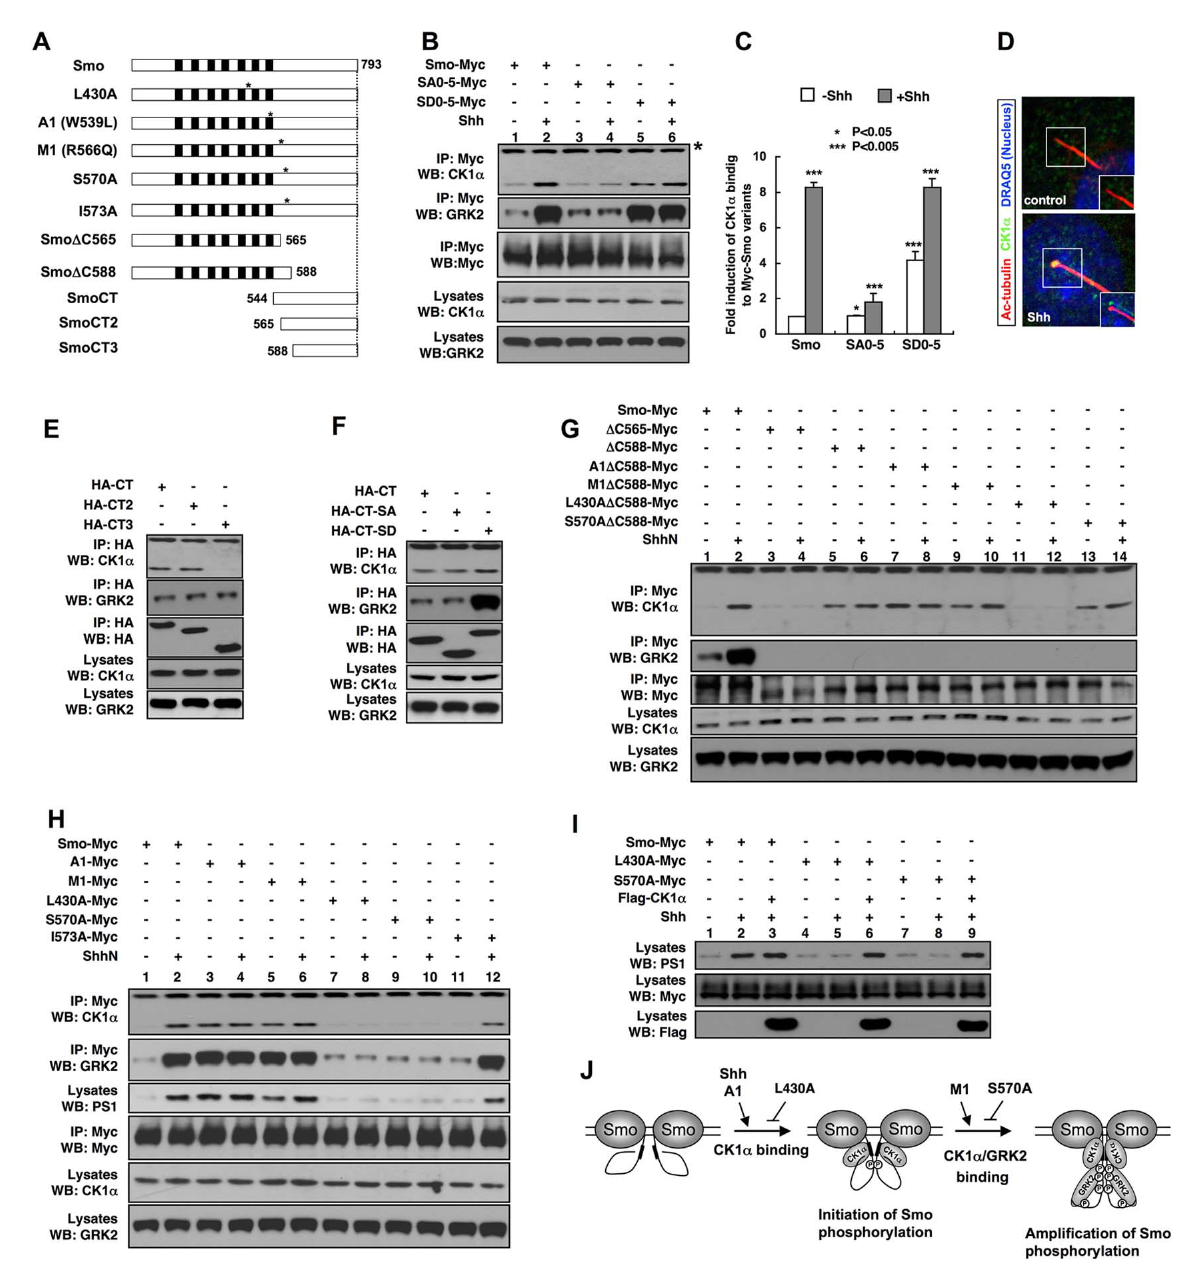
Figure 7. Shh promotes CK1 a /GRK2 binding to Smo. (A) Schematic drawings of full-length and truncated Smo with point mutations indicated by the asterisks. Black boxes denote the transmembrane domains. L430A is located in the third intracellular loop; A1 in the seventh transmembrane domain; M1, S570A, and I573A are located in the membrane proximal region of the Smo C-tail. (B–C, E–H) Coimmunoprecipitation assays to determine the interaction between CK1 a /GRK2 with different forms of Smo. NIH 3T3 cells were transfected with the indicated Myc-tagged or HA- tagged Smo constructs, followed by immunoprecipitation and western blot analysis with indicated antibodies. Cell lysates were also directly immunoblotted by the indicated antibodies. Histogram in (C) shows the quantification of (B) with CK1 a binding normalized by the Smo input and compared with lane 1. * p , 0.05, ** p , 0.01, *** p , 0.005. Western blots were quantified using the ImageJ software followed by Prism analysis, n =3. Quantifications of (G) and (H) are shown in Figure S5. (D) NIH 3T3 cells untreated (control) or treated with Shh-conditioned medium were immunostained to show the expression of acetylated tubulin (red), CK1 a (green), and DRAQ5 (blue). Images in the insets are shifted overlays of the selected fields. (I) NIH 3T3 cells were transfected with the indicated Myc-tagged Smo constructs either alone or together with a Flag-tagged CK1 a construct and treated with or without Shh-conditioned medium, followed by immunoprecipitation and western blot analysis with the indicated antibodies. Cell lysates were also directly immunoblotted by the indicated antibodies. (J) A model for how Smo phosphorylation is regulated by Shh. See text for details.